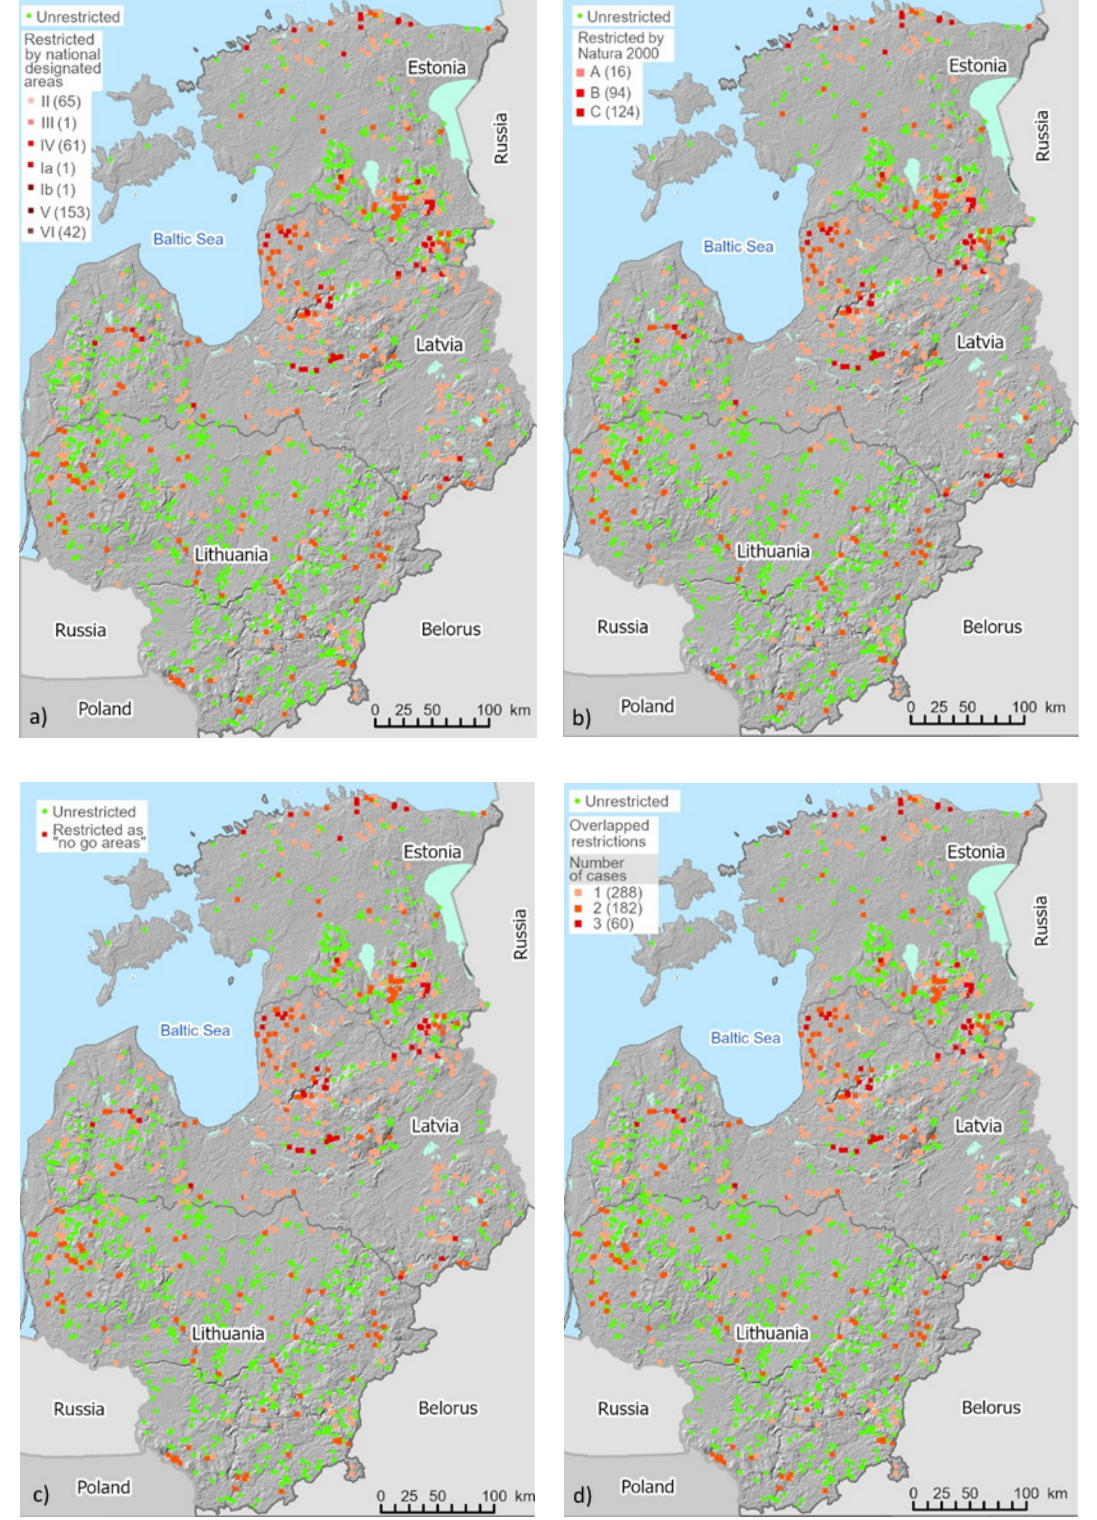
Figure 12. Historic and currently nonpowered dam sites in environmentally sensitive areas: ( a ) in nationally designated areas, ( b ) in Natura 2000 areas, ( c ) in “no-go areas” and ( d ) overlapping restrictions (Source: © Esri, © USGS SRTM, open street map contributors). Note: numbers in brackets indicate the number of